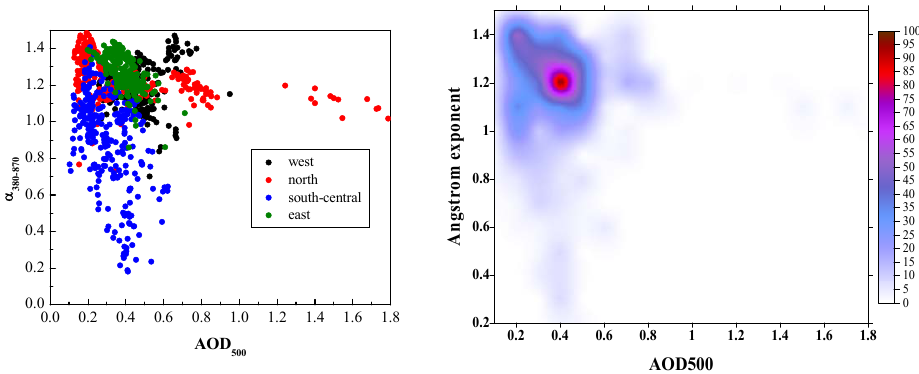
Fig. 5. Correlation between AOD 500 and α 380 − 870 in the different BoB sub-regions (left) and density plot of AOD 500 vs. α 380 − 870 correla- tion over entire BoB